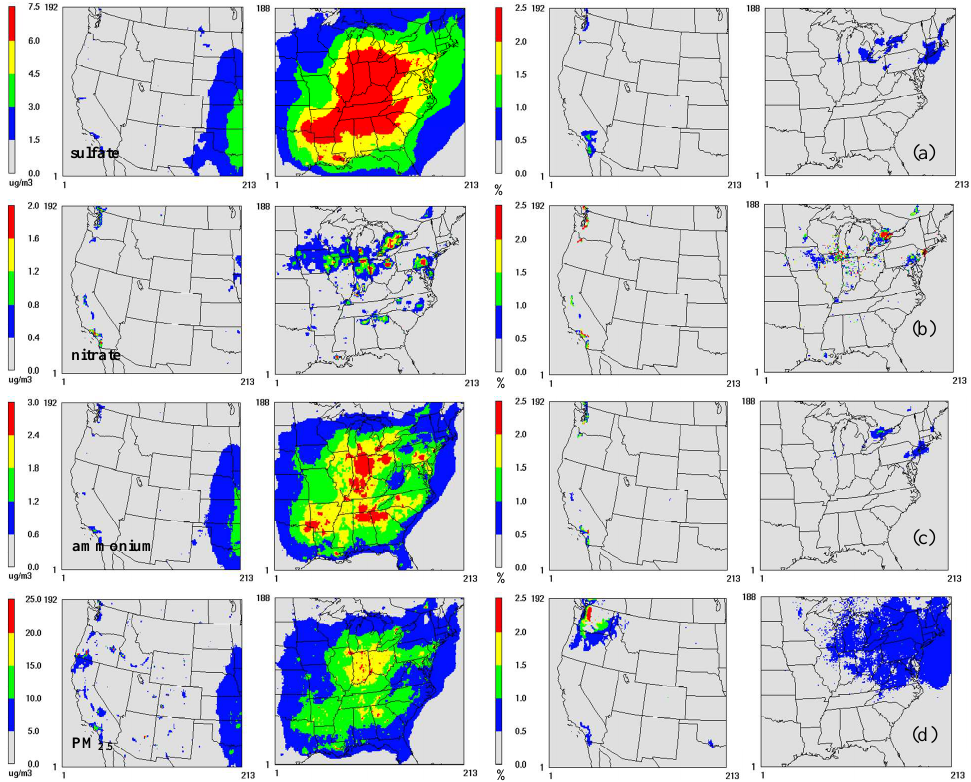
Fig. 10. (a) Monthly mean aerosol sulfate with CB05-Base and percent increase in mean aerosol sulfate between CB05-TU and CB05- Base (b) mean aerosol nitrate with CB05-Base and percent increases in mean aerosol nitrate between CB05-TU and CB05-Base (c) mean ammonium with CB05-Base and percent increases in mean ammonium between CB05-TU and CB05-Base (d) mean PM 2 . 5 with CB05-Base and percent increases in mean PM 2 . 5 between CB05-TU and CB05-Base. In each row, the first two plots represent mean values (µgm − 3 ) and the last two plots represent percent changes